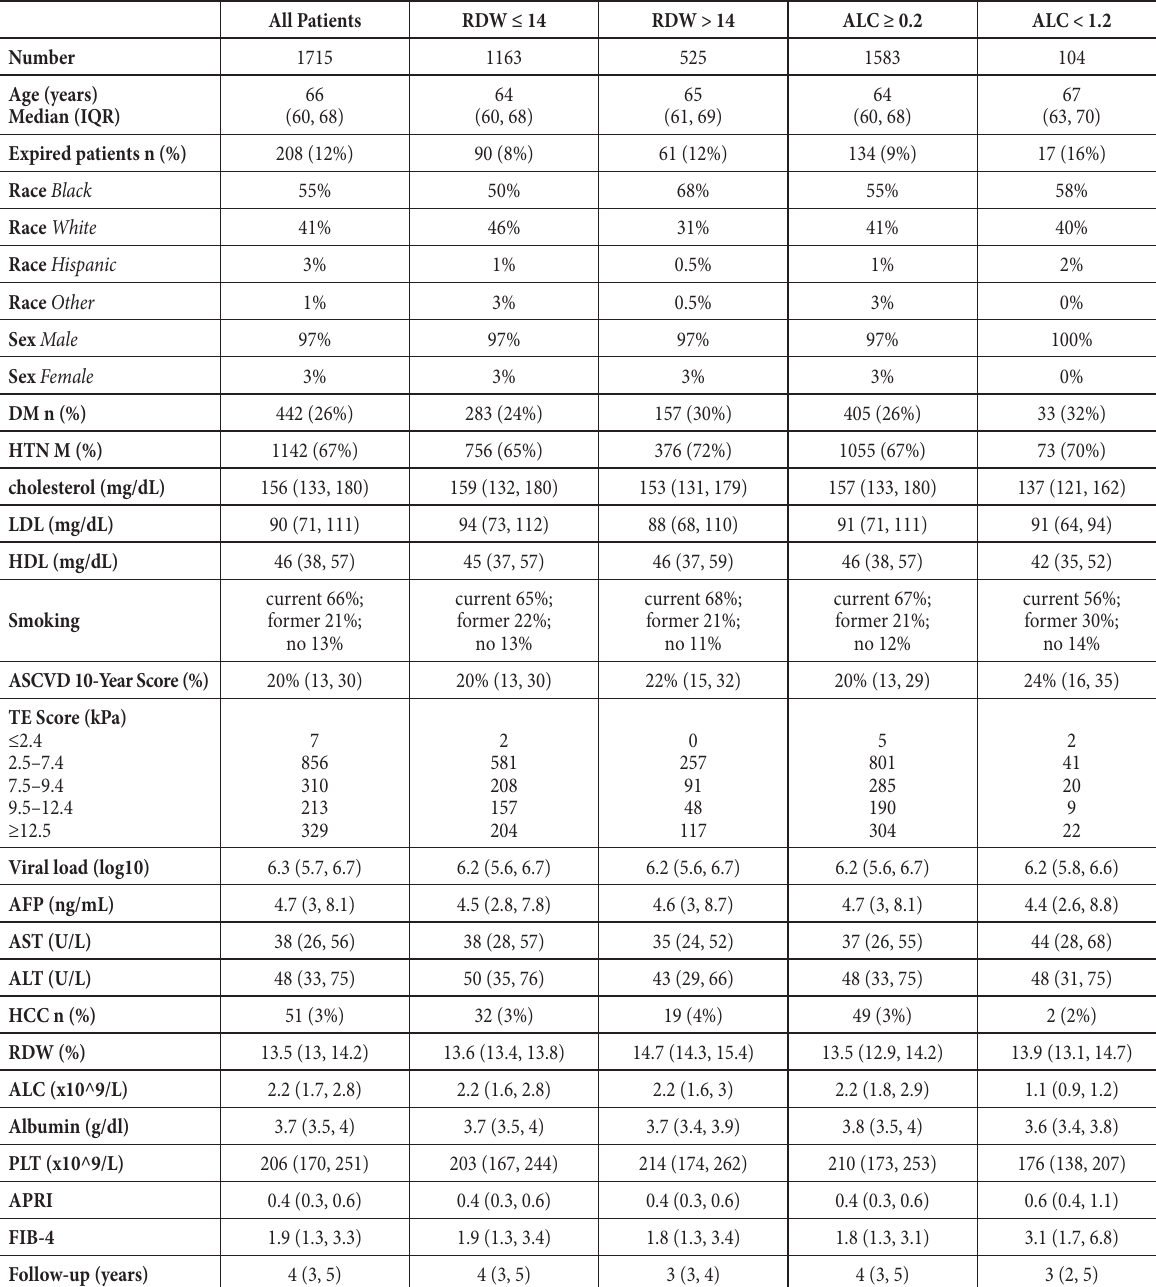
Table 1. Study Cohort